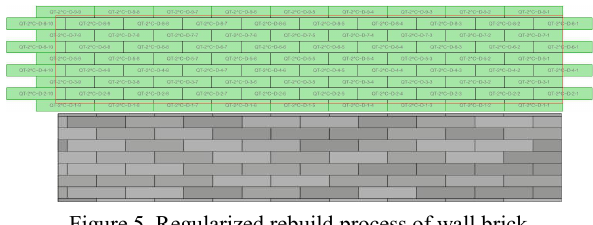
Figure 5. Regularized rebuild process of wall brick